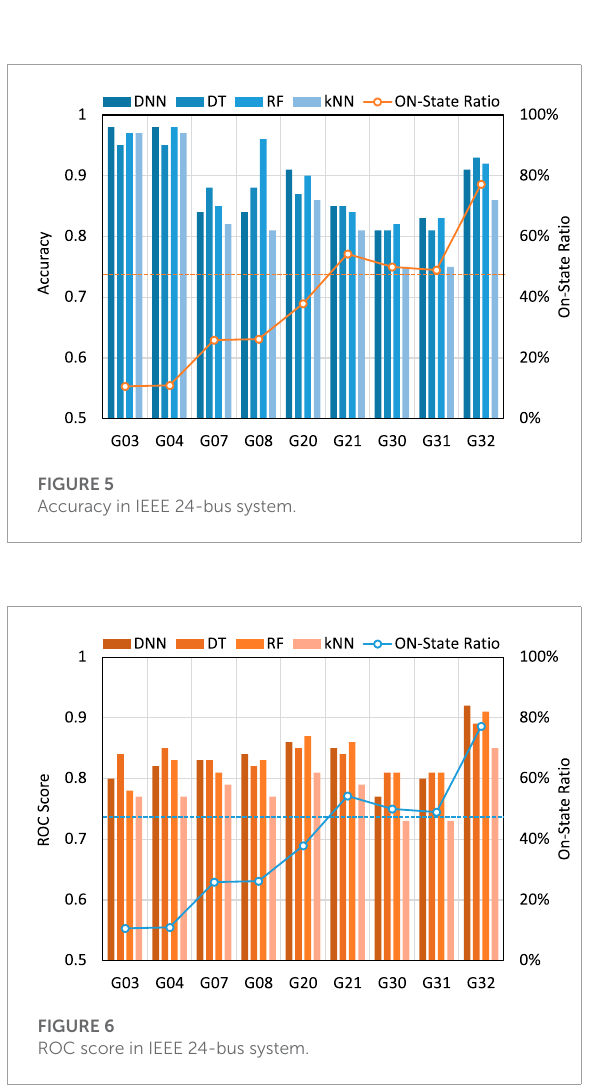
FIGURE 6 ROC score in IEEE 24-bus system.